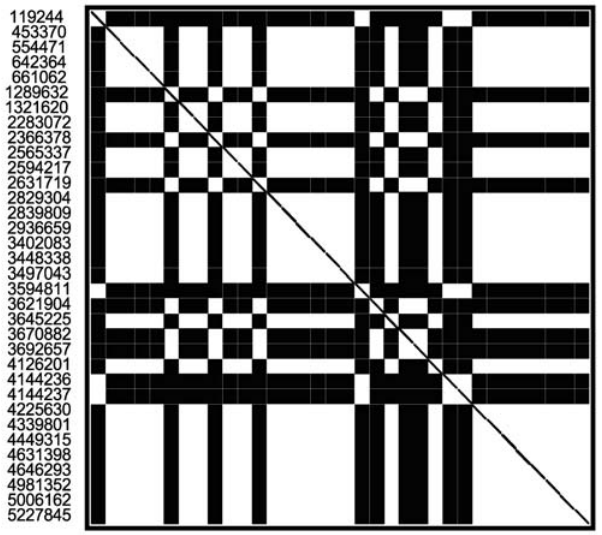
Figure 4. Compatibility matrix of parsimony informative SNPs. The genome positions are numbered to the left of the matrix. Black squares indicate incompatible sites, where nucleotide changes are inferred to have occurred multiple times either due to recombination or repeated mutation. White squares represent compatible sites, at which all nucleotide changes can be inferred to have occurred only once in a phylogeny.